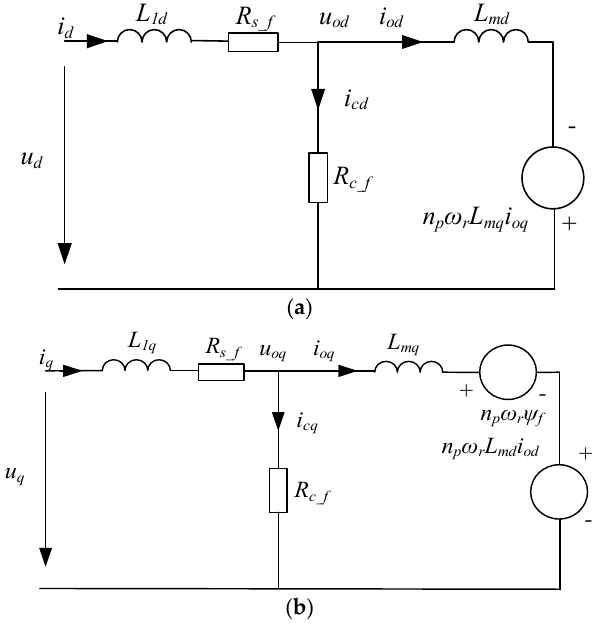
Figure 4. Fundamental mathematical model of PMSM. ( a ) Fundamental motor model in the d -axis; ( b ) fundamental motor model in the q -axis.